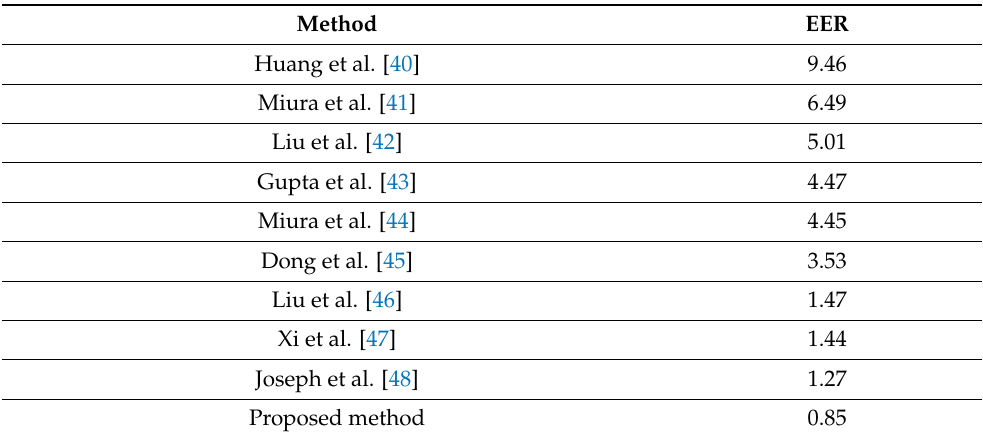
Table 8. Comparisons of EER by the state-of-the-art methods and the proposed method in case of training with SDUMLA-HMT-DB and testing with HKPolyU-DB (unit: %).